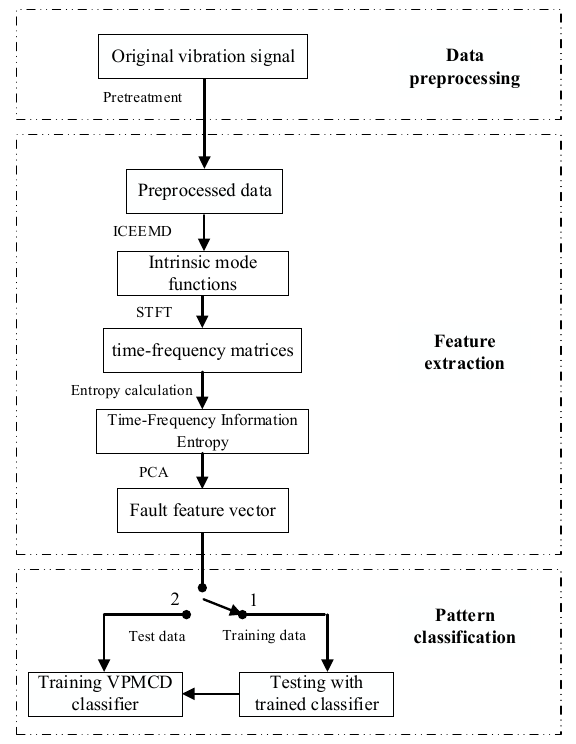
Figure 5. The fault diagnosis procedure for a planetary gearbox.